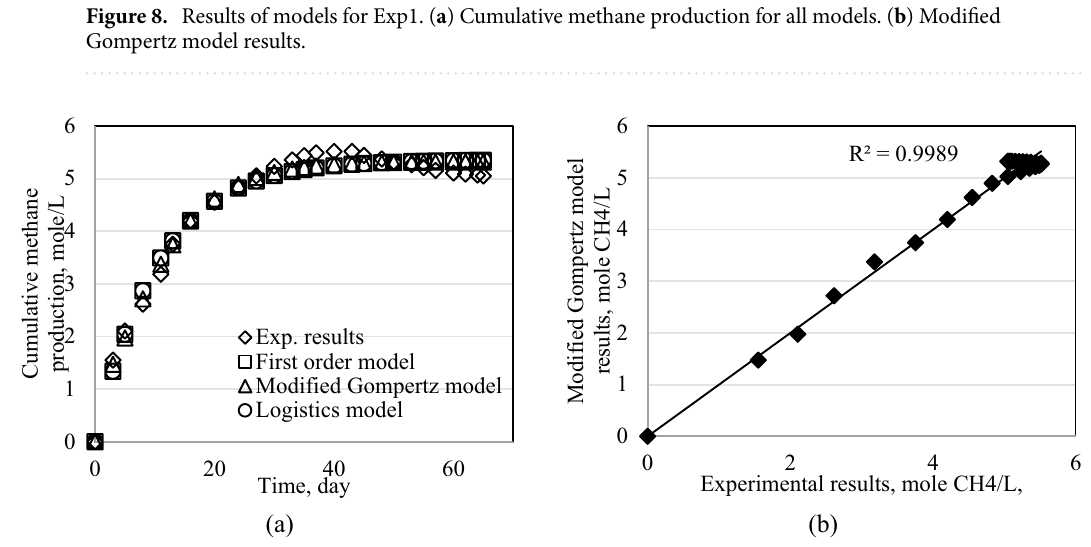
Figure 9. Results of models for Exp2. ( a ) Cumulative methane production for all models. ( b ) Modified Gompertz model results.